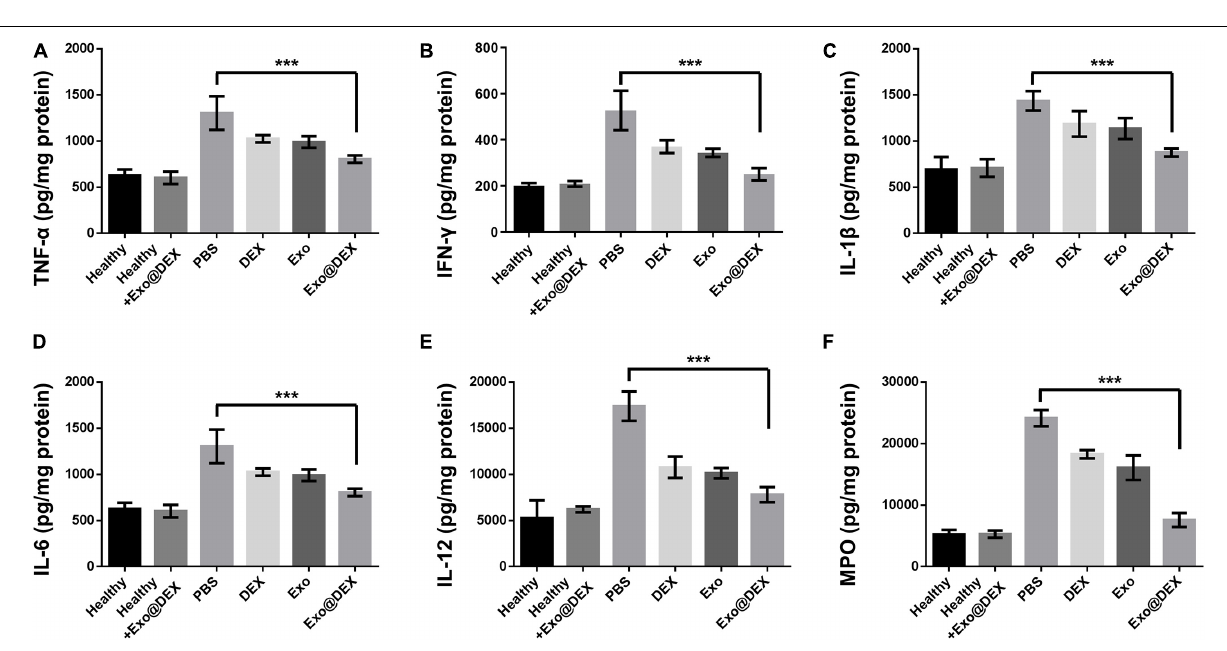
Frontiers in Bioengineering and Biotechnology |